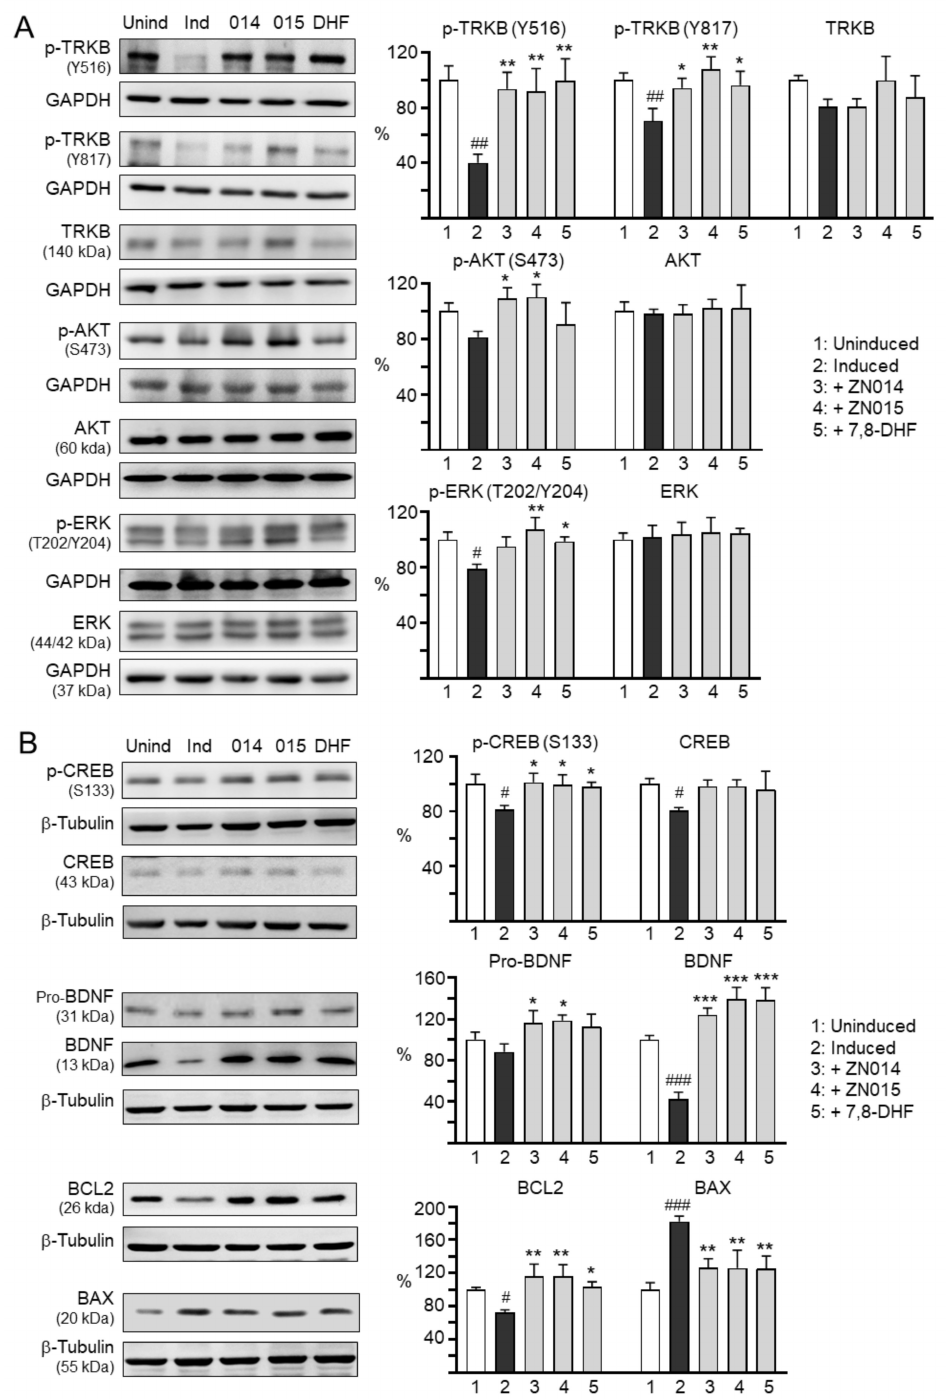
Figure 4. Molecular targets of ZN014 and ZN015 in SH-SY5Y cells expressing A β -GFP. 7,8-DHF (5 µ M) was included as a positive control. Relative ( A ) TRKB, p-TRKB (Y516 and Y817), AKT, p-AKT (S473), ERK, p-ERK (T202/Y204), ( B ) CREB, p-CREB (S133), precursor pro-BDNF, mature BDNF, BCL2, and BAX protein levels were analyzed by immunoblotting using specific antibodies ( n = 3). Glyceraldehyde-3-phosphate dehydrogenase (GAPDH) ( A ) or β -tubulin ( B ) was used as a loading control. Relative protein levels are shown on the right side of the representative Western blot images. The relative protein level in uninduced cells (Dox − ) was normalized (100%). p -values: comparisons between induced and uninduced cells ( # : p < 0.05, ## : p < 0.01, ### : p < 0.001), or between treated and untreated cells (*: p < 0.05, **: p < 0.01, ***: p < 0.001) (one-way ANOVA with a post hoc Tukey